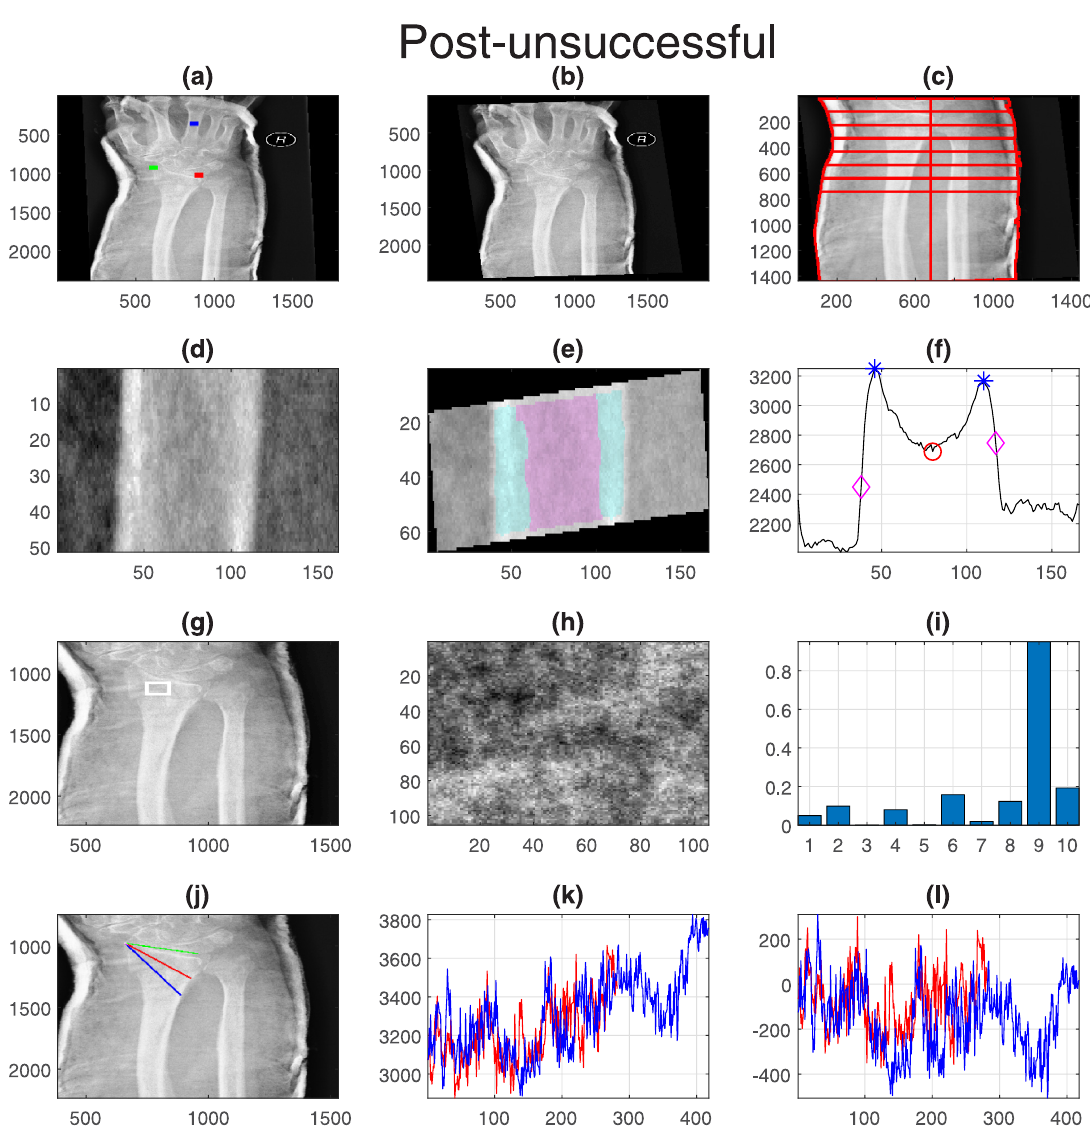
Fig 14. Post-unsuccessful: One representative case with all its measurements. Refer to Fig 11 for the caption.